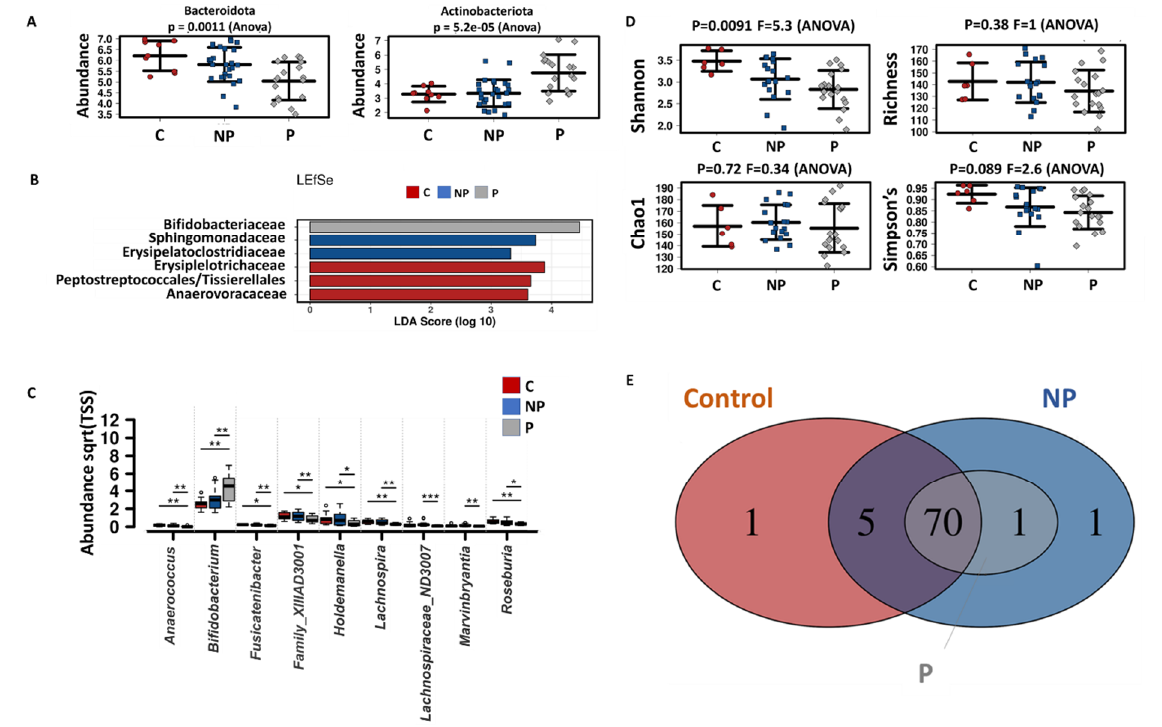
Figure 4. Effet of pasteurization of kefir on microbial modulation in vitro, including three different donors and two time points (24 h and 48 h). ( A ) Strip charts at phylum level of statistically significant differences between non-pasteurized and pasteurized samples. ( B ) Linear discriminant effect size (LEfSe) analysis family level. ( C ) Box plot of the abundance at genus level of statistically significant [ p < 0.05 (*), p < 0.01 (**), p < 0.001 (***)] differences between non-pasteurized and pasteurized samples. ( D ) Strip charts of Shannon, Richness, Chao1 and Simpson’s index. ( E ) Core microbiota plot at genus level, showing unique and common features to the different treatment groups. Sqrt(TSS) = square root total sum of squares.